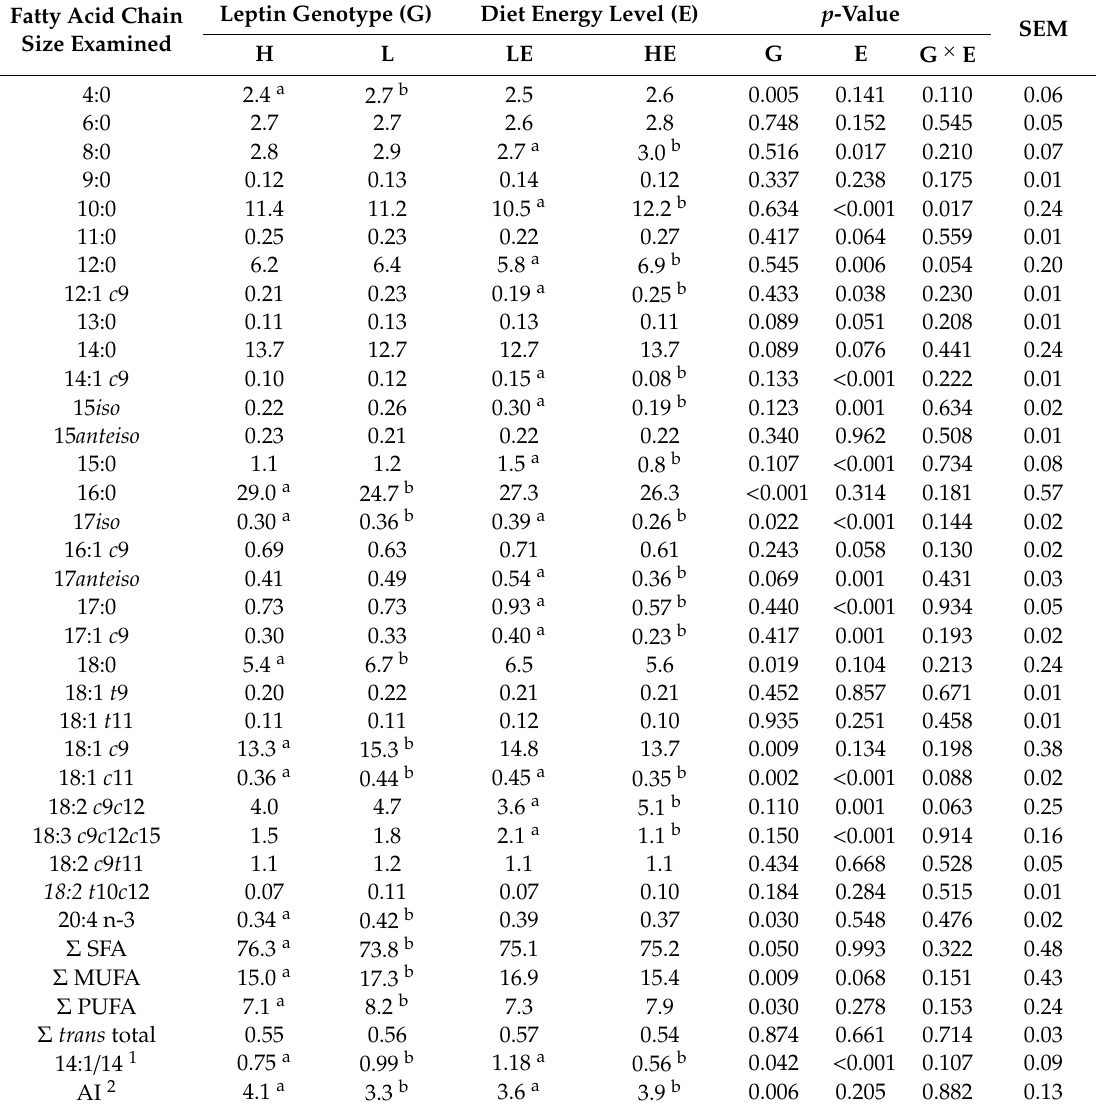
Table 4. E ff ects of leptin genotype and energy level of diet on milk fatty acid